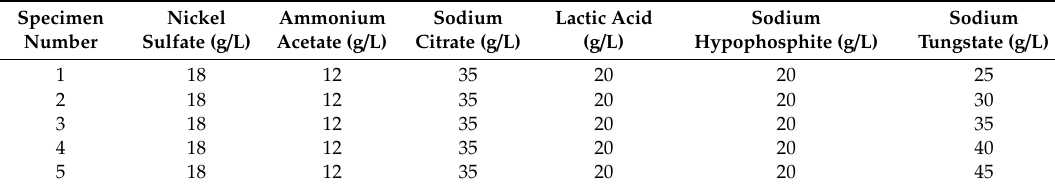
Table 3. Main components of electroless Ni-W-P plating solution.